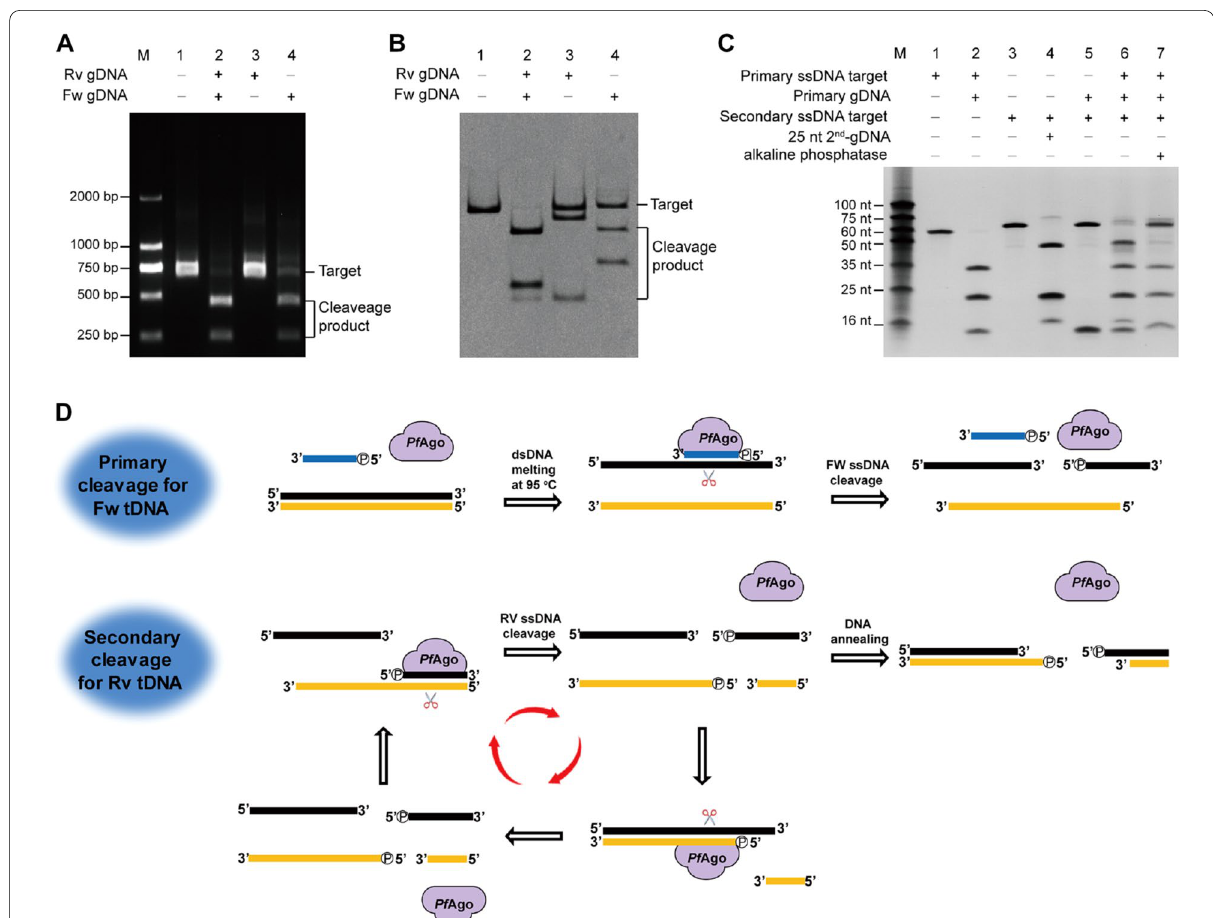
Fig. 1 Pf Ago-targeted DNA cleavage mediated by a single gDNA. A A single gDNA can mediate Pf Ago activity for 600-nucleotide (bp) long DNA targets to produce DNA cleavage products. B A single gDNA can assist Pf Ago-mediated cleavage of 95-bp DNA targets, producing distinct banding patterns from reactions containing a pair of gDNAs. C A cleavage fragment with a 5 ′ -phosphate end can function as a renewed gDNA that can initialize an additional round of DNA cleavage if the reverse complement sequence of the original target is present. D Schematic of single gDNA-assisted Pf Ago-mediated activity for targeted DNA